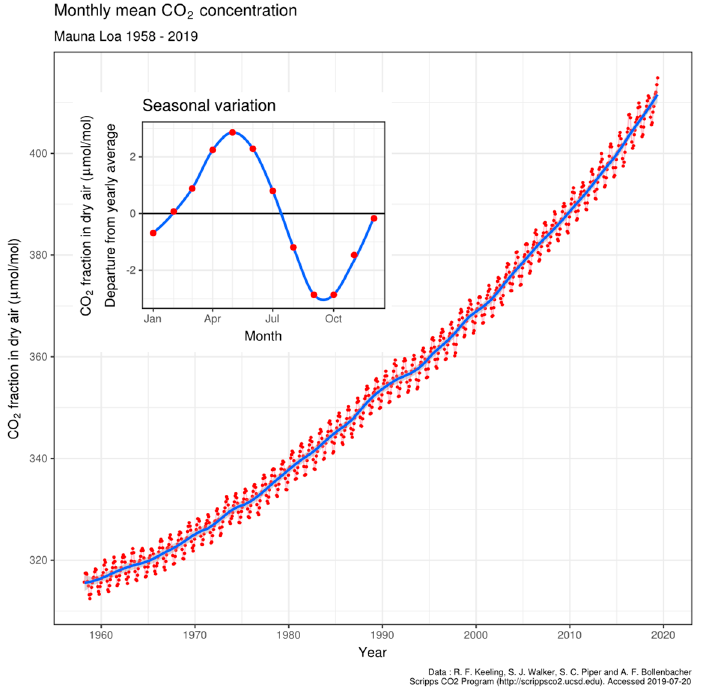
Figure 1. The Keeling curve of atmospheric CO 2 partial pressure at 3200 m on Mauna Loa, Hawaii. Data from Dr. Pieter Tans, NOAA/ESRL and Dr. Ralph Keeling, Scripps Institution of Oceanography. CC BY-SA 4.0, https://commons.wikimedia.org/w/index.php?curid=40636957, accessed on 12 November 2022.